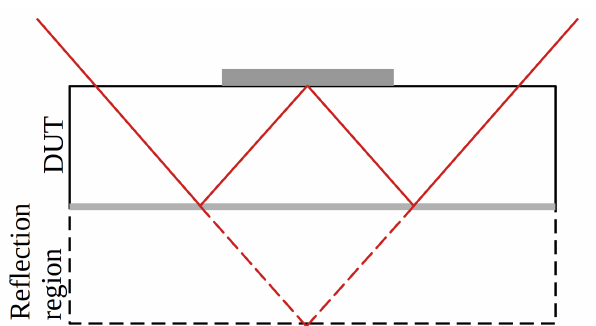
Figure 7. Schematic of the mirror technique using orthogonal laser beam incidence. The reflection enables probing below the strip metallisation with illumination from the top. The path of the outermost light rays of the laser are shown as a continuous red line. The dashed red lines show the continuation of the light rays beyond the metallised back side. Metallisations are depicted in